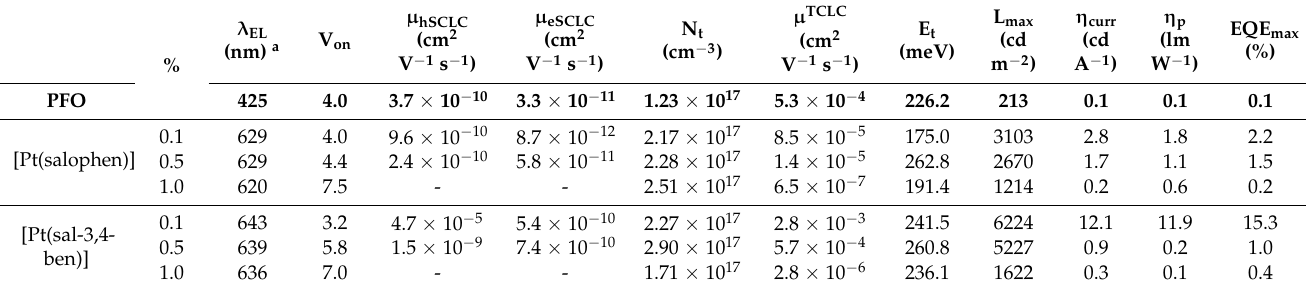
Table 3. PFO:[Pt(salicylidenes)] WOLED charge-carrier characteristics and the figures of merit. ( a Values of the λ EL at the maximum peak band of each EL